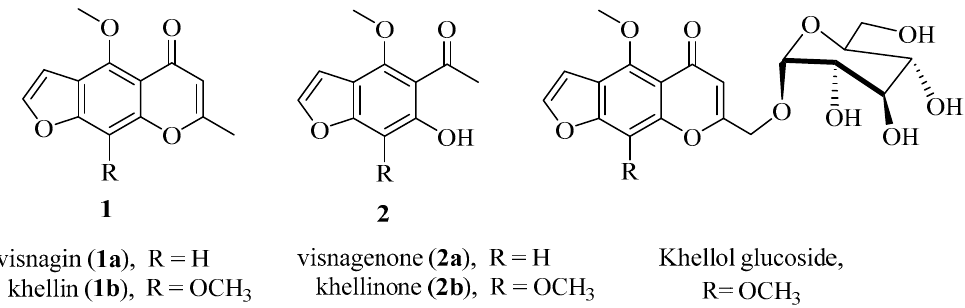
Figure 1. Chemical structure of furochromone derivatives.